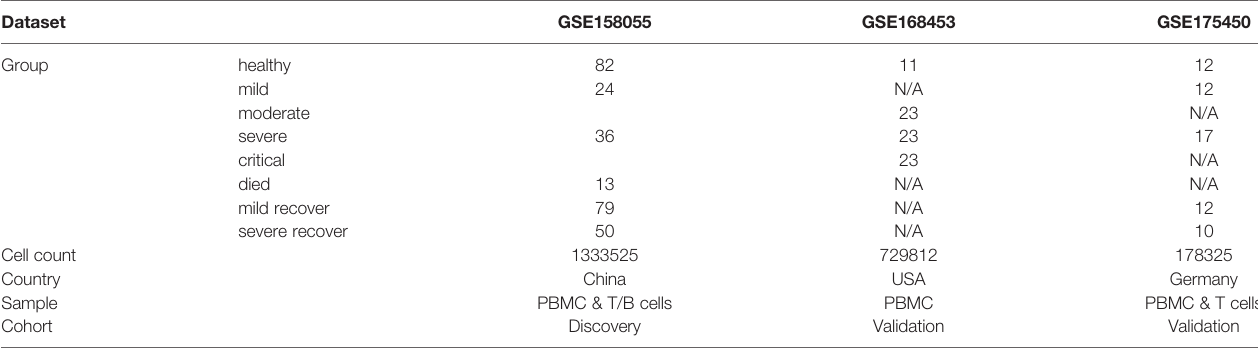
TABLE 1 | Information of single-cell datasets.